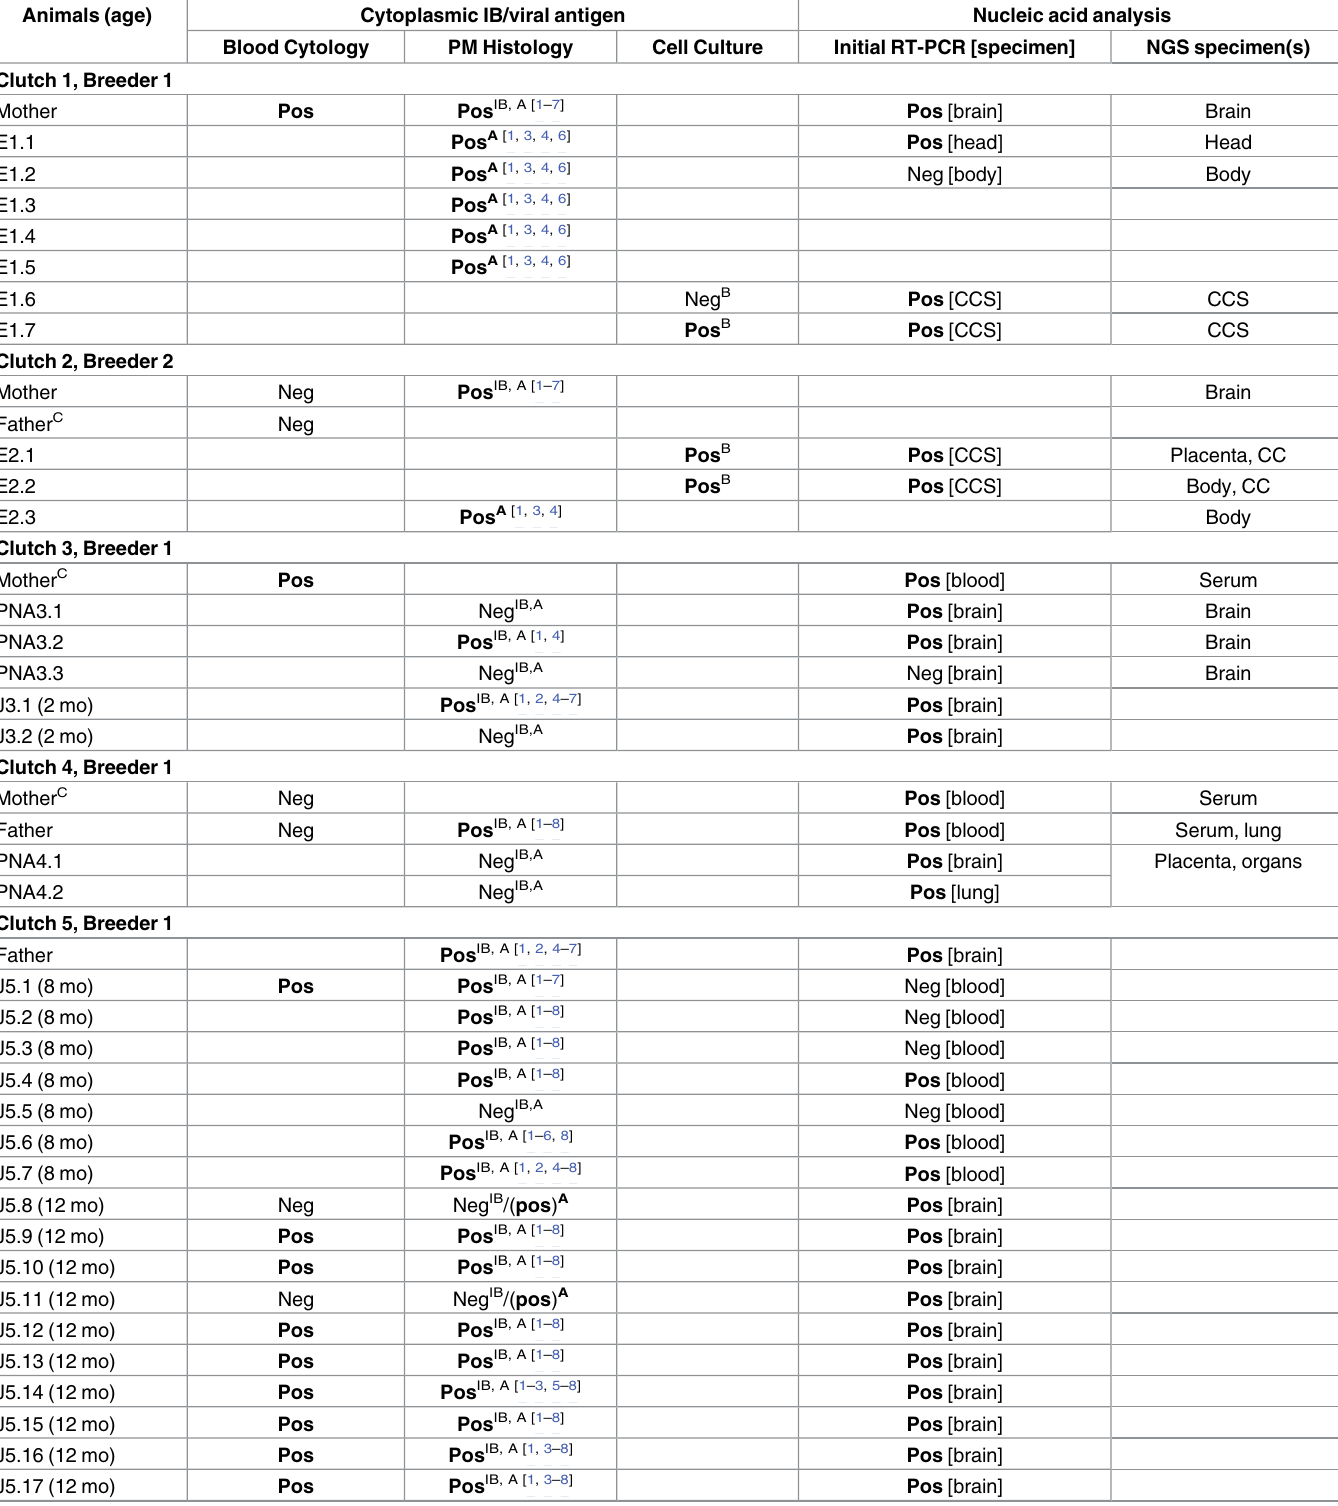
Table 1. Clutches, animals and tests performed on individual animals. Summary of results obtainedfor each animal. Animals